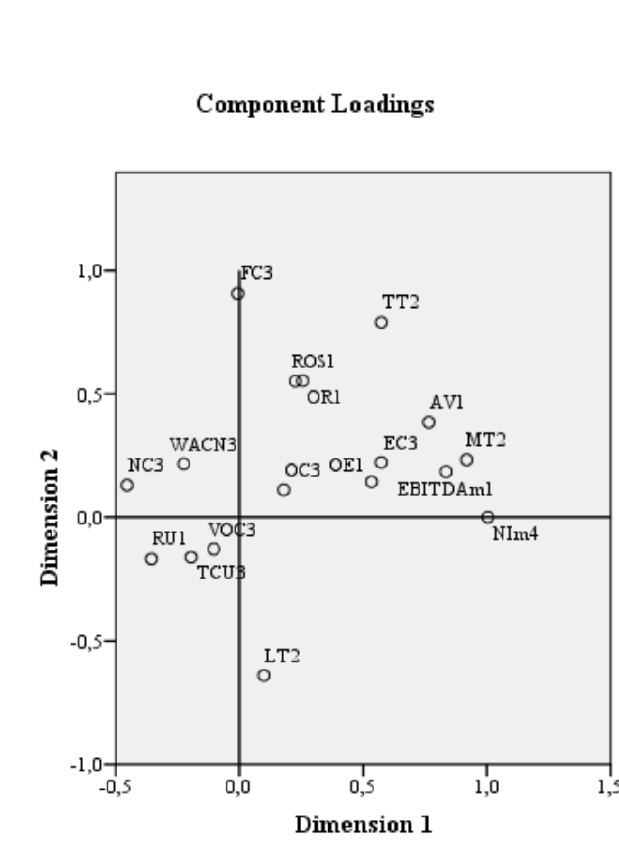
Figure 5. “Component Loadings 2008